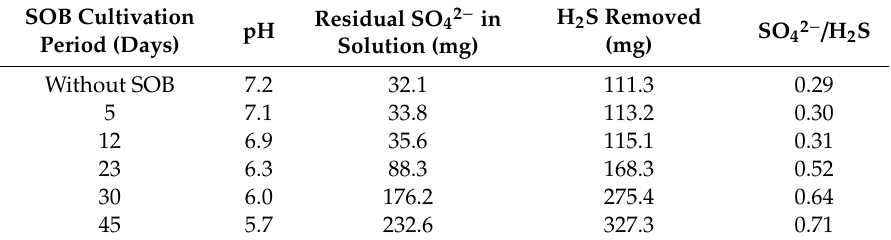
Table 1. Chemical properties of the examined solutions after